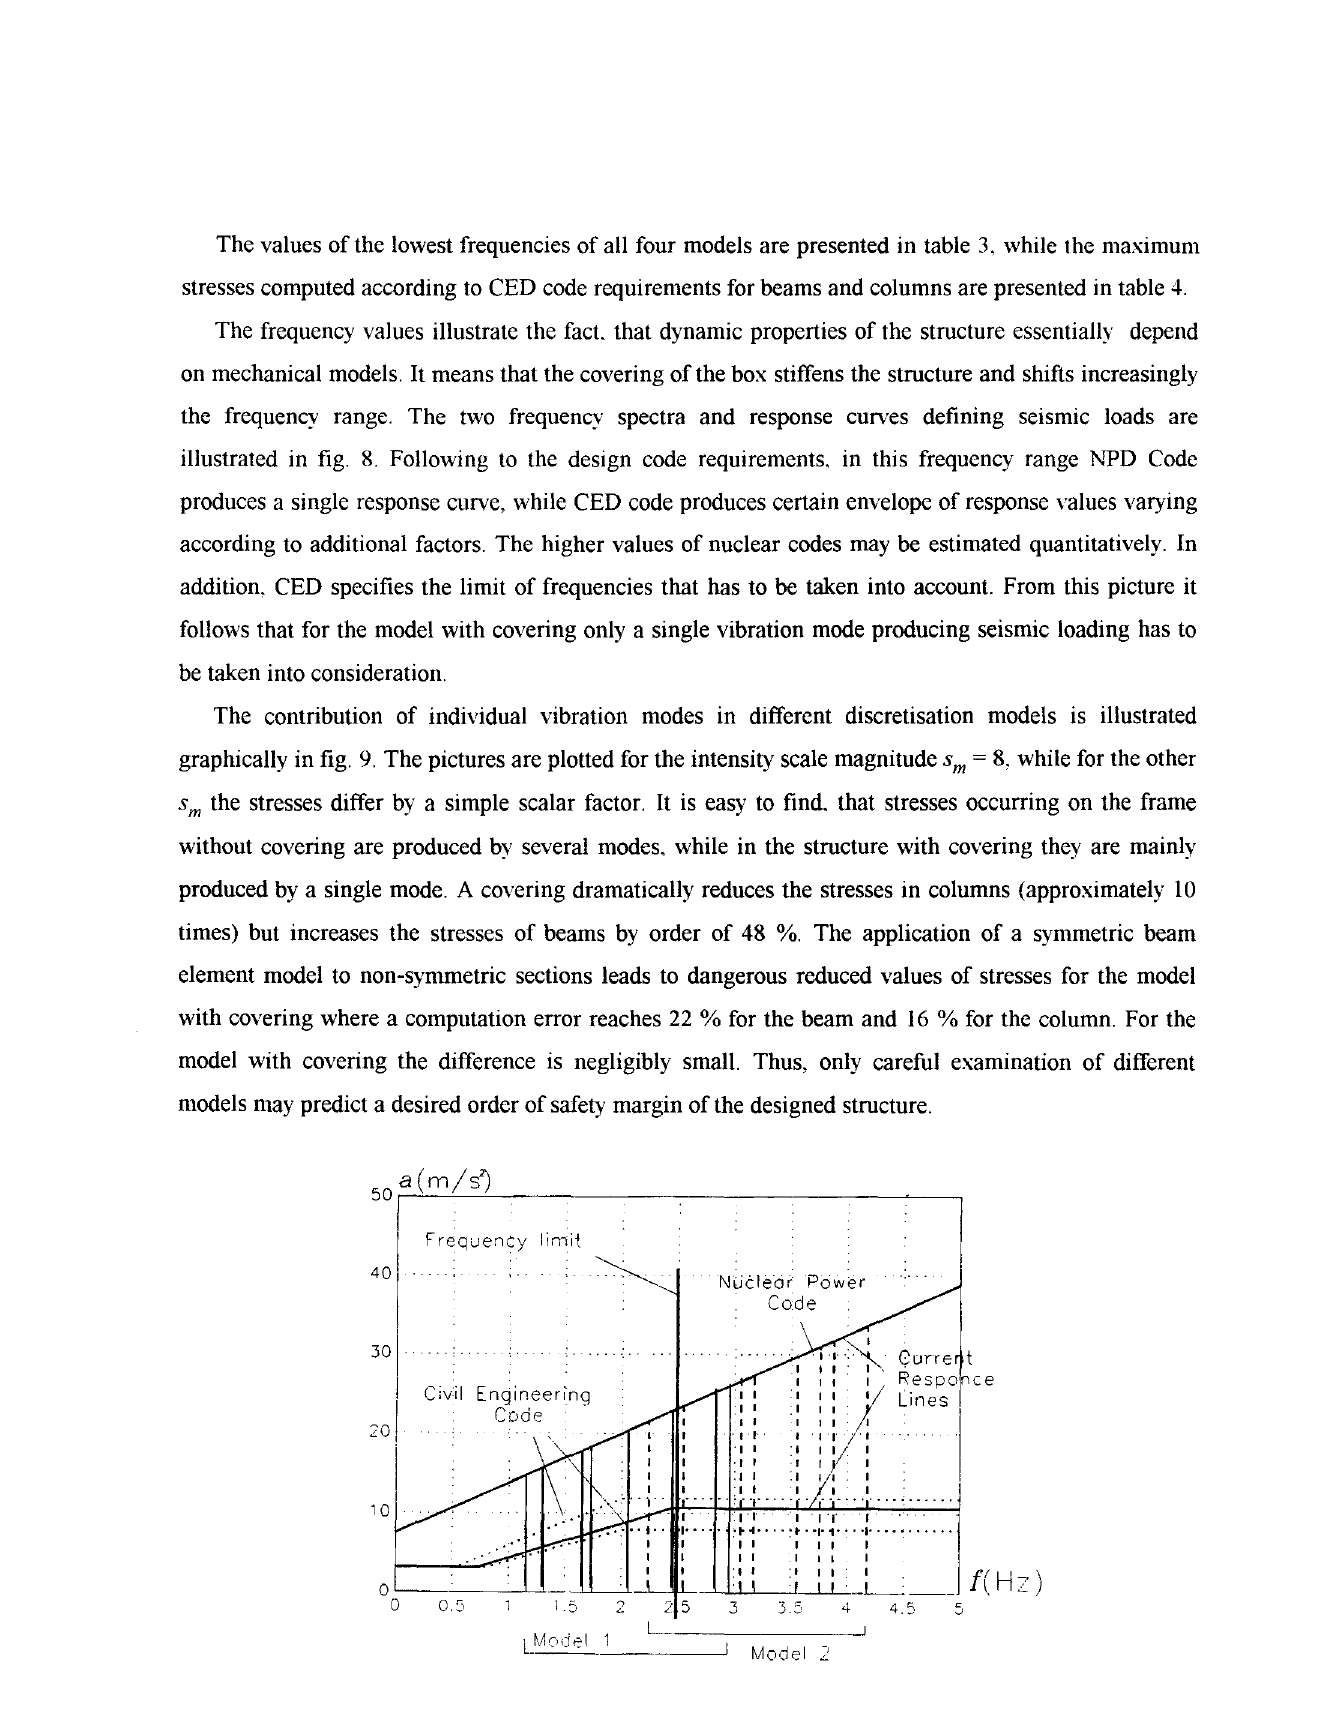
Fig. 8. Frequency spectra and response